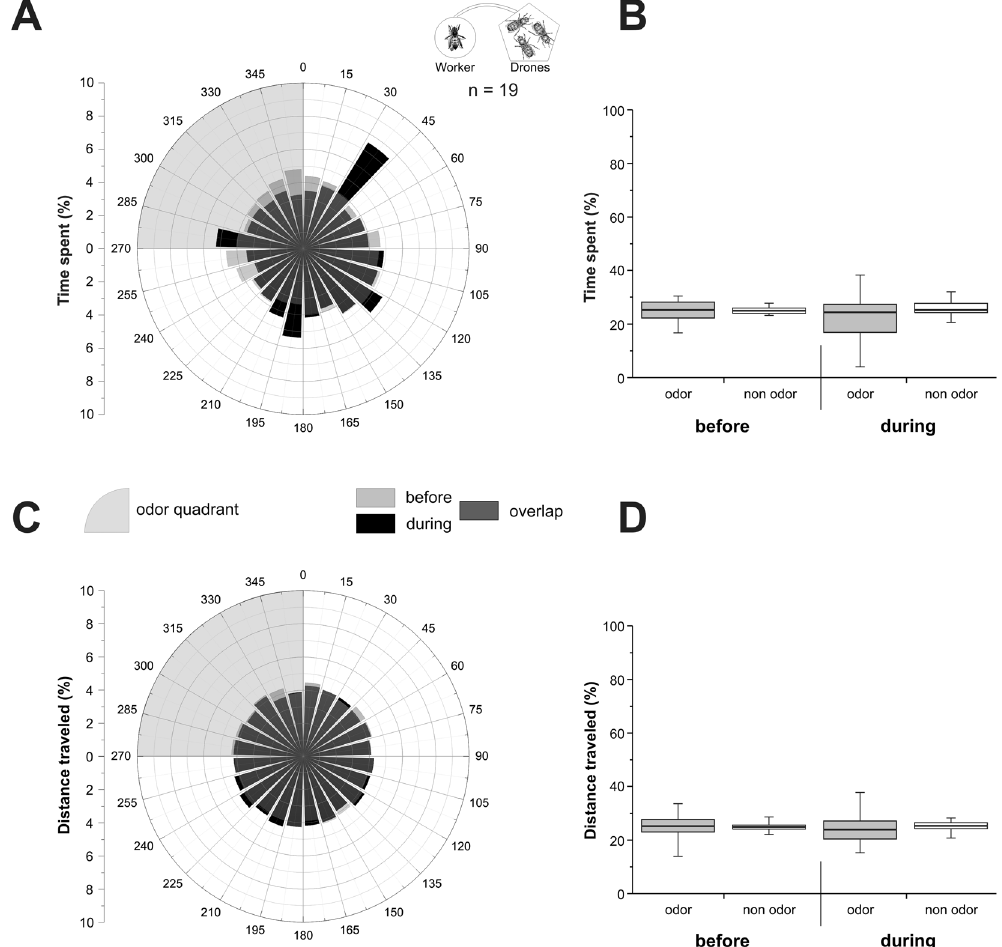
Figure 4. Experiment 3: workers’ response to drone odour bouquet. Workers’ behaviour on the walking simulator, when stimulated with the odour bouquet of 10 drones. ( A , C ) Circular histograms showing the percentage of time spent ( A ) or of distance travelled ( C ) by workers according to 15° sectors, with the odour quadrant being represented on the upper left (grey area). Light grey bars represent the 5 min before odour stimulation (‘before’), black bars represent the 5 min during stimulation (‘during’), and hence, dark grey bars show the overlap of the two phases. ( B , D ) Histograms of the percentage of time spent ( B ), or of distance travelled ( D ) by workers in the odour quadrant (gray box) and on average in the three odourless quadrants (white box) before and during odour